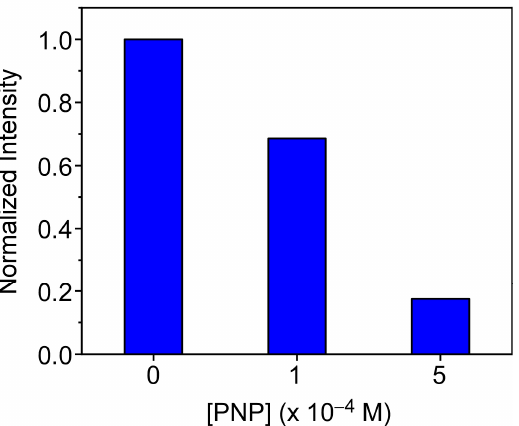
Figure 8. Effect of PNP on the fluorescence intensity of PFO@AETA hydrogels ( λ x = 396 nm, λ m = 438 nm).